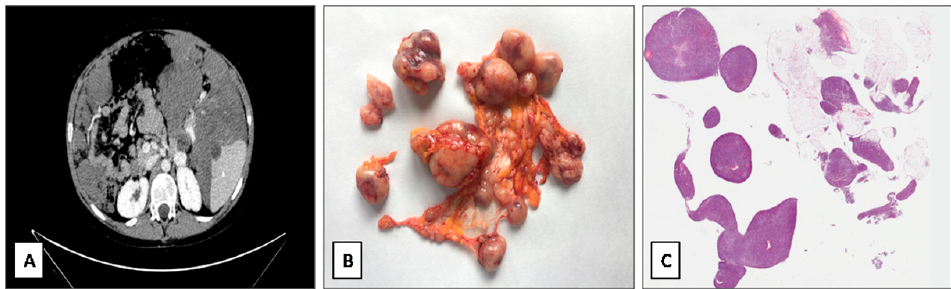
Figure 1. ( A ) Computer Tomography imaging showing multiple intra-abdominal, confluent and mass-forming nodules, affecting the entire abdomen and pelvis. ( B ) Gross examination showing multiple, whitish in colour, omental nodules. ( C ) Histological examination. Low magnification showing the histologic correspective of the gross appearance of the tumor: multiple hypercellular nodules within omental tissue (hematoxylin and eosin; original magnification 25×).